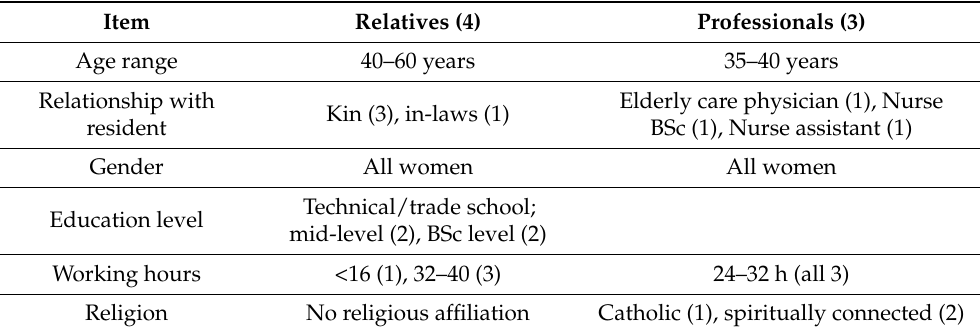
Table 3. Characteristics of persons interviewed in the ethnographic